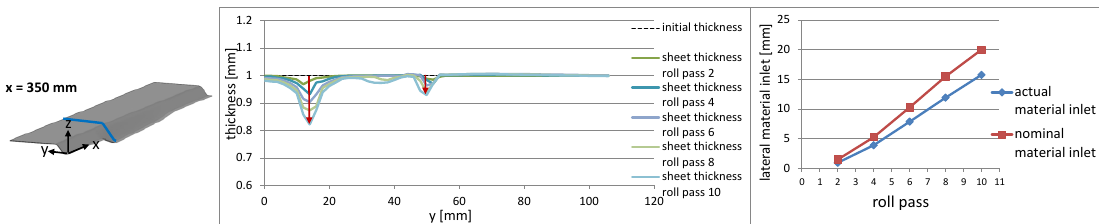
Figure 20. Sheet thicknesses in the cross-sections at x = 0, 200, 350 mm.